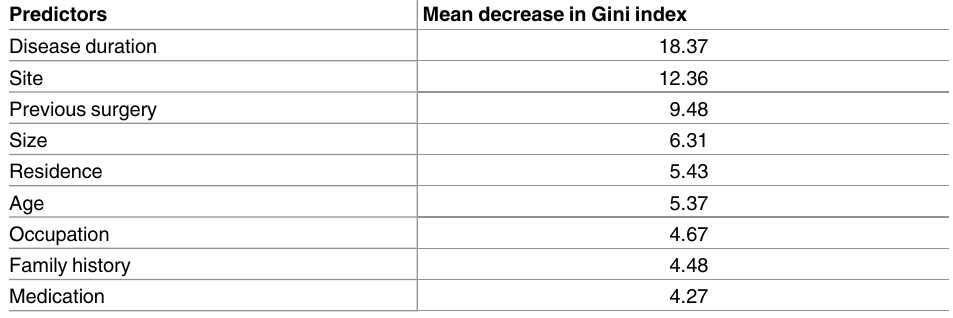
Table 2. Relative importance of predictors on recurrence of eumycetoma using random